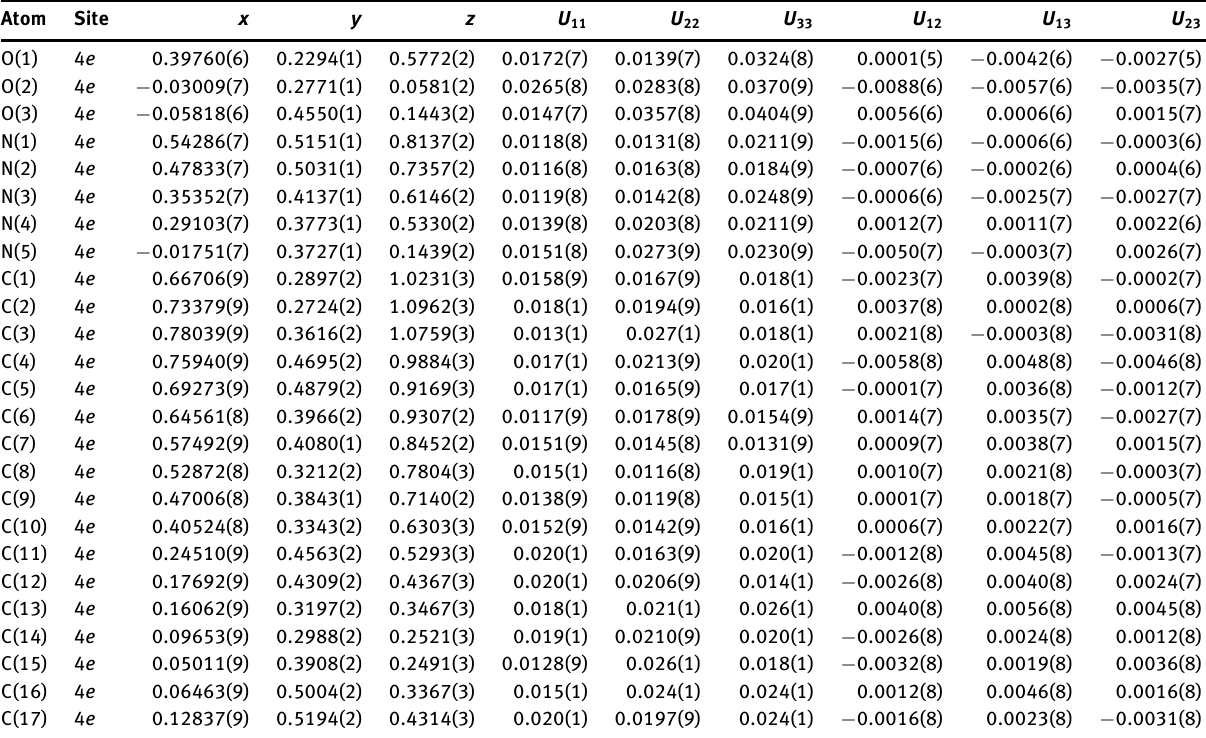
Table 3: Fractional atomic coordinate and displacement parameters (Å 2